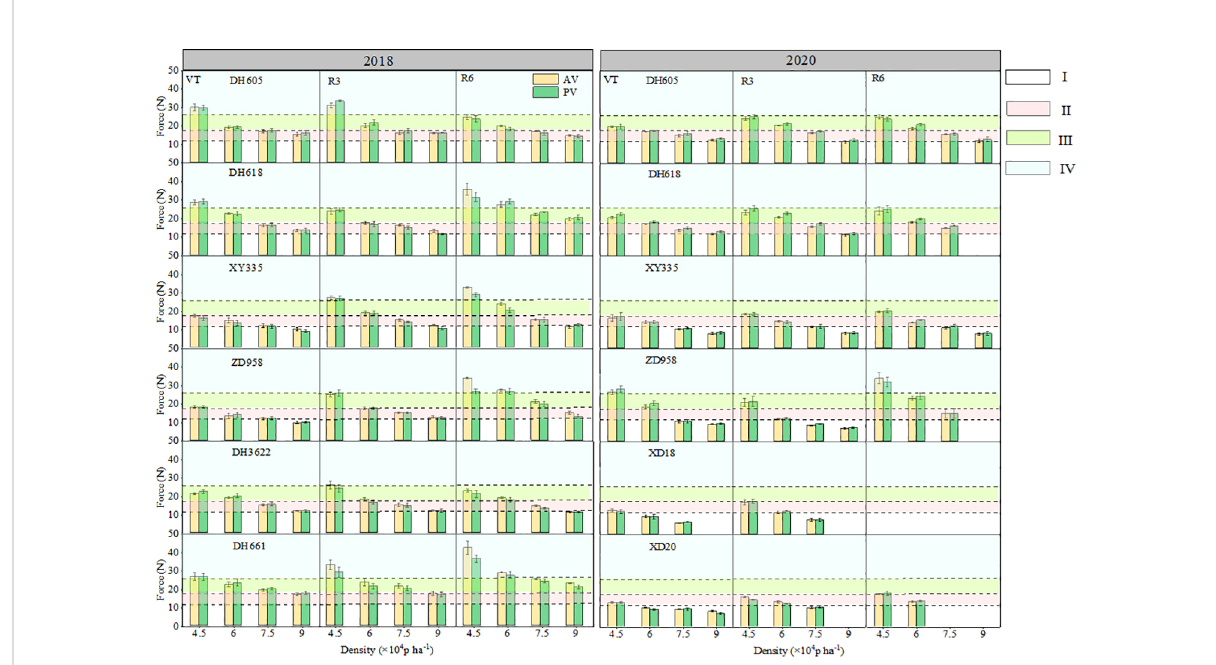
FIGURE 6 Measurement of lodging resistance of six varieties in different densities of maize plants. I: inferior lodging resistance, II: medium lodging resistance, III: high lodging resistance range, IV: strong lodging resistance. VT, fl owering period; R3, grain fi lling period; R6, maturation period; AV, actual measured value F max value; PV, presumptive value. The missing value of the force indicates that the angle at which the plant breaks is less than